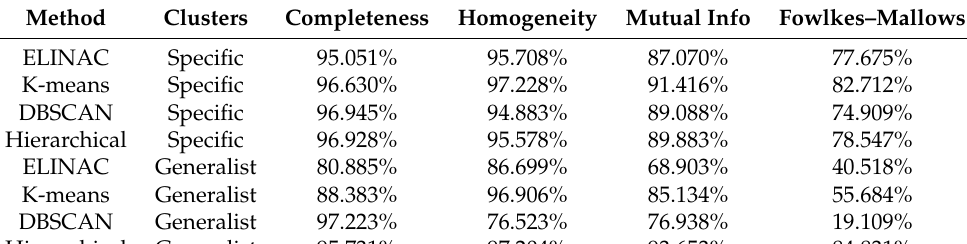
Table 5. Performance evaluation of ELINAC compared to other literature approaches.